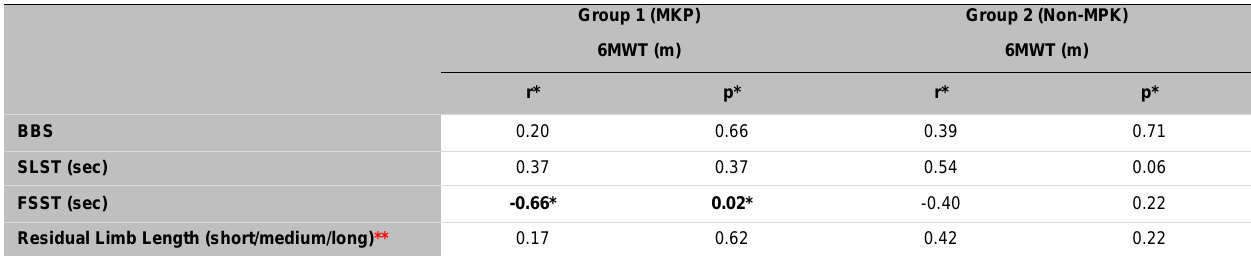
Table 6: Correlation between 6MWT, FSST, BBS, SLST and residual limb length within the two